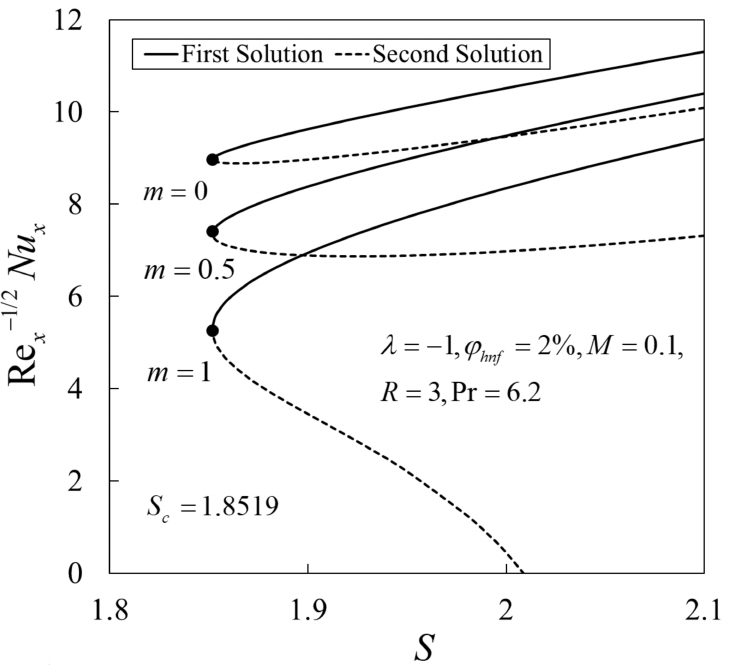
Figure 8. Variations of the local Nusselt number Re − 1/2 x Nu x against suction parameter S for different values of m .